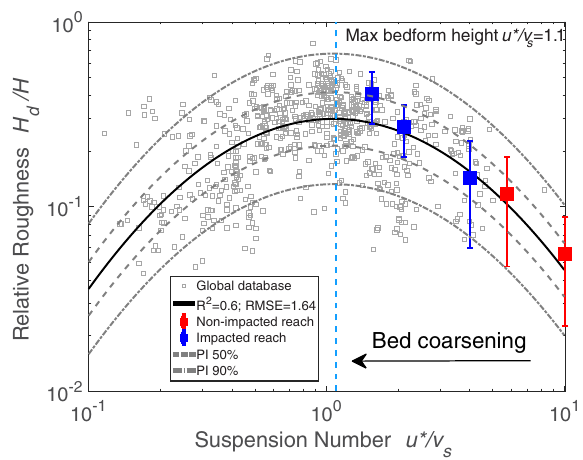
Fig. 2 Relation between relative bedform (roughness) height and suspension number. A comprehensive database (gray squares), including both laboratory and fi eld data, is compiled to determine the hump-shaped relation (solid line) between relative bedform height and suspension number, where H d is dune height [L], H is water depth [L], u * is shear velocity [LT − 1 ], and v s is the sediment settling velocity [LT − 1 ]. Although such hump-shaped relations are well recognized 27,29,30 , a well-tested quantitative relation remains lacking heretofore. The proposed relation, based on a parabolic equation in logarithmic space, range of laboratory and fi eld data. The comparison among the proposed relation, the compiled database and other relations are given in Supplementary Fig. S2. Field observations of bedform heights in the dam- impacted (blue squares) and non-impacted reach (red squares) of the lower Yellow River (LYR) agree with the proposed relation very well. The squares represent the mean value of relative bedform height and error bars represent one standard deviation. In particular, the observed data from the non-impacted reach of the LYR quantify a previously-untested region of the proposed relation. As shown in Supplementary Table S3, the difference in suspension number (and thus bedform geometry) in the impacted and non- impacted reaches results mainly from bed coarsening. The hump-shaped relation indicates that if the bankfull suspension number is greater than a suspension number corresponding with the dune-size maximum (~1.1 via present model; vertical blue dashed line), bed coarsening induced by damming on the river will result in larger dunes during fl oods. Dashes and dashed-dotted lines represent the 50% and 90% prediction intervals (PI) of the present model,